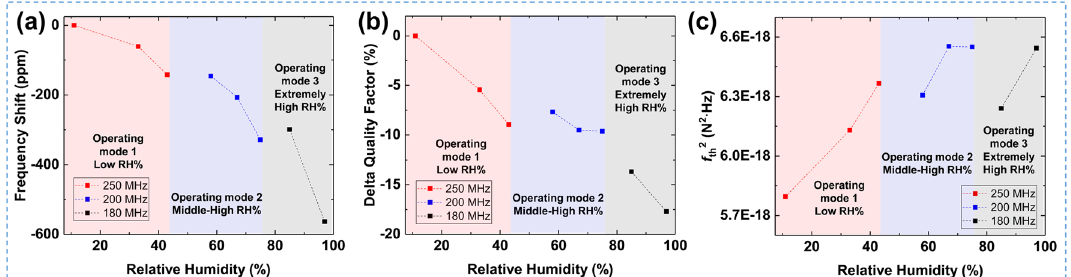
Figure 5. The resonance characteristics and thermal noise force responses by selecting the operating frequency according to the exposed RH conditions. ( a,b ) The frequency shifts and Q responses of the selected SAWR as the function of RH conditions. ( c ) Thermal noise forces along with the selected SAWR under the various RH conditions.